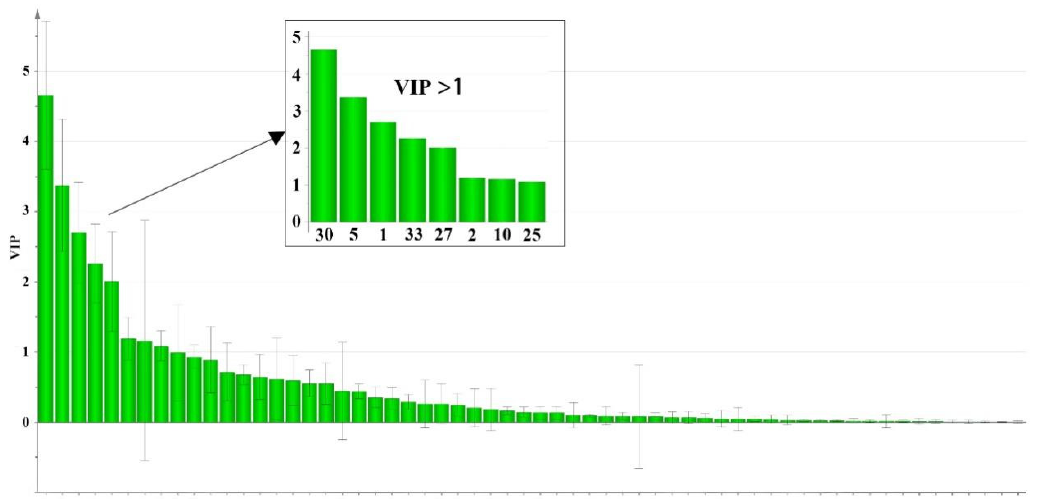
Figure 5. VIP for classification of ES and WS. The X -axis numbers denoted are the same as those in Table 1. The eight constituents of VIP >1 are shown in the enlarged